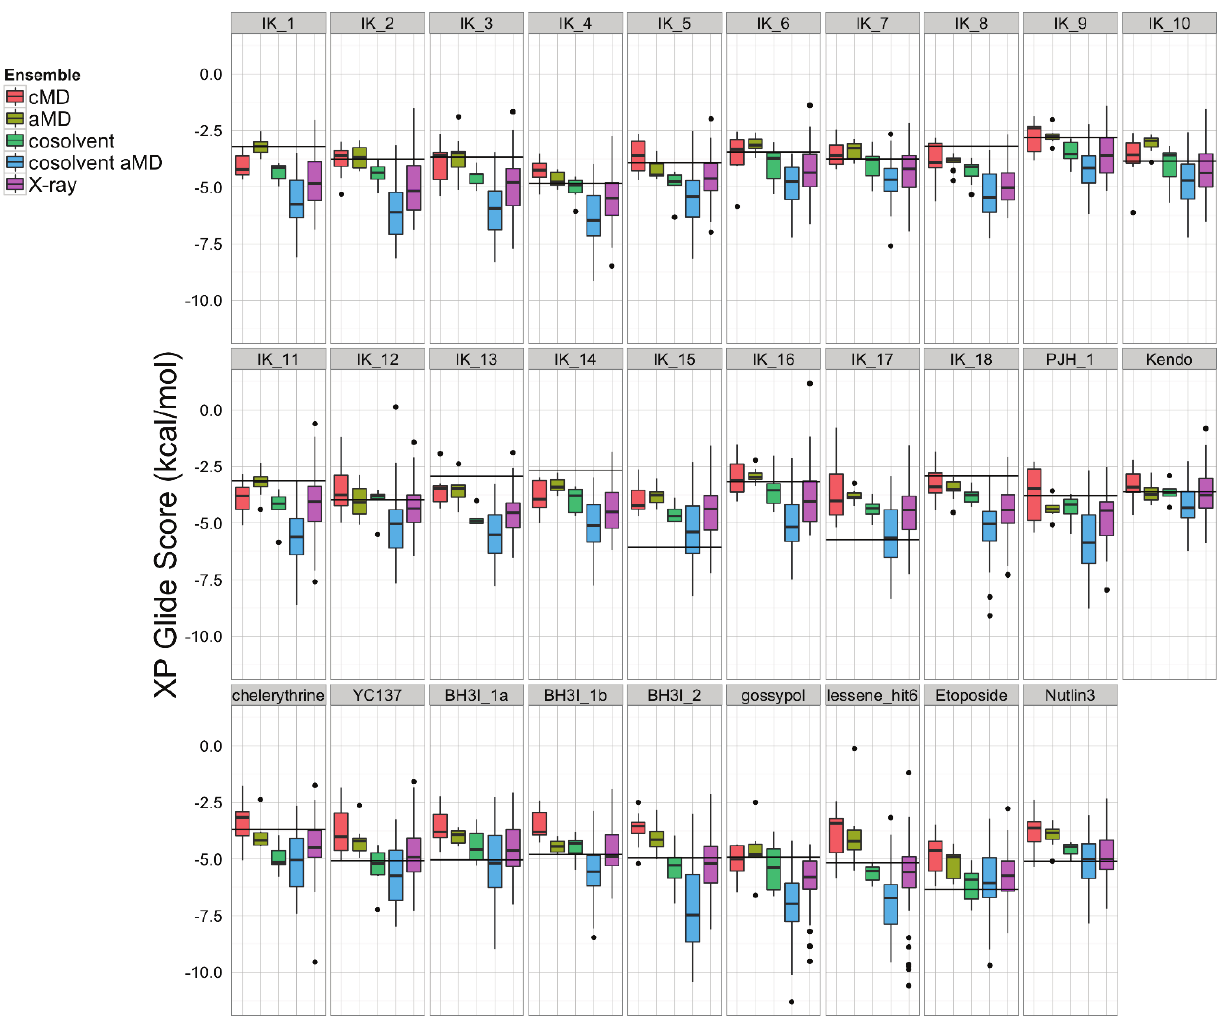
Figure 5. A set of 27 known Bcl-xL inhibitors and two decoy compounds were docked against the simulated and experimental structure ensembles. The distributions of docking scores for each ligand (individual panels) from each ensemble are shown as box-and-whisker plots with outliers as black dots. Docking with the cosolvent aMD (blue)-derived conformations yielded the best overall scores. The horizontal black line in each panel denotes the score achieved by docking against the single X-ray apo structure from which simulations were initiated (see Experimental Section for